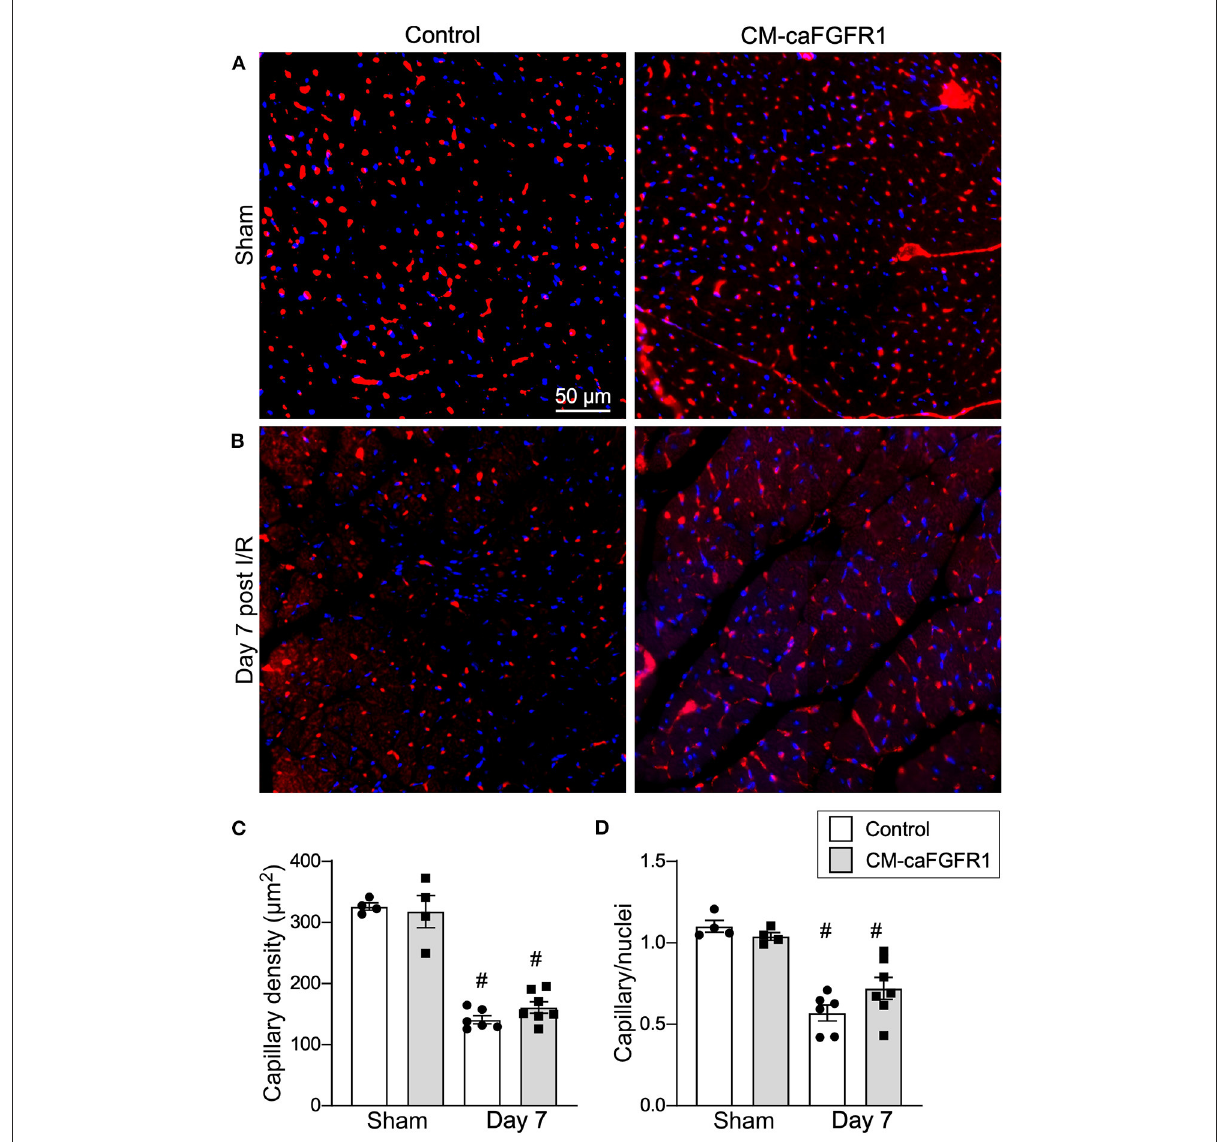
FIGURE7 Myocardial capillary density after cardiac I/R injury is not affected by transient FGFR1 activation in myocytes. (A,B) Representative images of immunoflurescence for CD31 (red) and DAPI (blue) showing capillaries in the periinfarct area of Control and CM-caFGFR1 mice at 7 days after sham operated (A) or I/R injury (B) . Scale bar = 50 µ m. (C,D) Quantitation of capillary density normalized to area (C) or to nuclei (D) showing a significant capillary rarefaction in the peri-infarct area 7 days after I/R injury without a notable difference in capillary density between Control and CM-caFGFR1 hearts. # P < 0.05 vs.